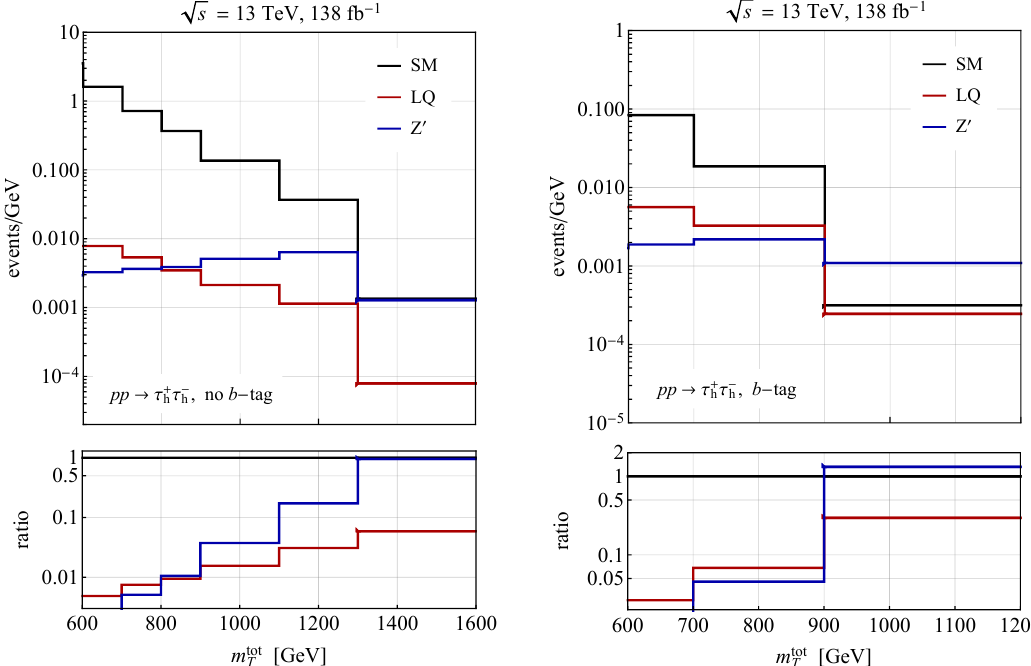
Figure 9 . As figure 6 but comparing a LQ and a Z 0 signal hypothesis. The black curves correspond to the SM expectations of the DY background provided by CMS in the publication [54]. The red curves represent the LQ NLO predictions assuming g 4 = 1 , M U = 2 TeV and M G 0 = 2 TeV , while the blue histograms illustrate the LO Z 0 predictions for g 0 such as the choice of the flavour-dependent Z 0 -boson couplings ζ ij